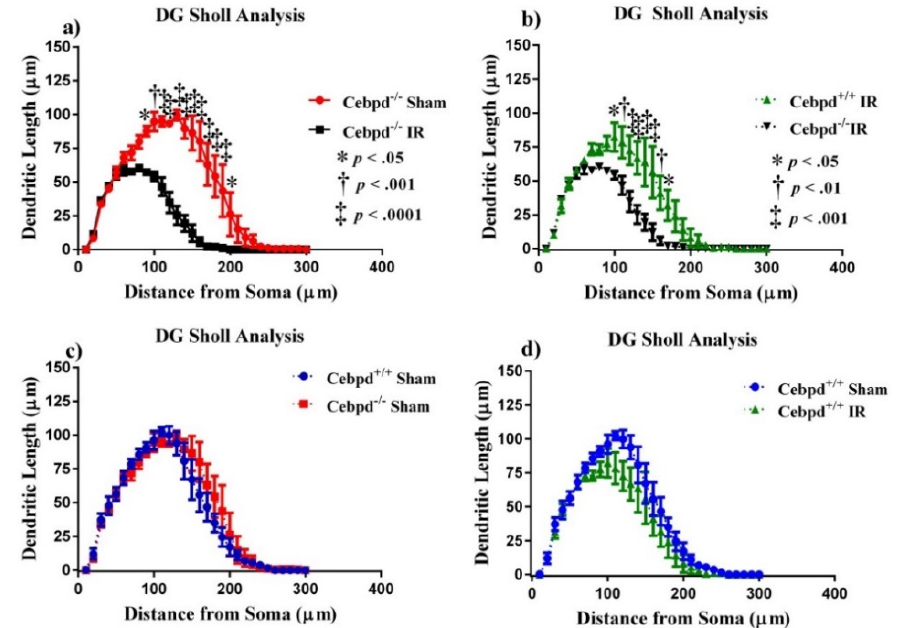
Figure 3. Sholl analyses of neurons in the dentate gyrus. ( A ) Dendritic length, measured by Sholl analysis, radiation greatly decreased length at 90–100 µ m from the soma when Cebpd − / − -sham were compared to Cebpd − / − -IR. ( B ) Treatment decreased length at 100–170 µ m from the soma when Cebpd +/+ -IR were compared to Cebpd − / − -IR. There were no significant differences observed when ( C ) Cebpd +/+ -sham were compared to Cebpd − / − -sham or ( D ) Cebpd +/+ -sham were compared to Cebpd +/+ -IR. Average ± SEM ( n = 5); * p < 0.05, † p < 0.01. ‡ p < 0.001.